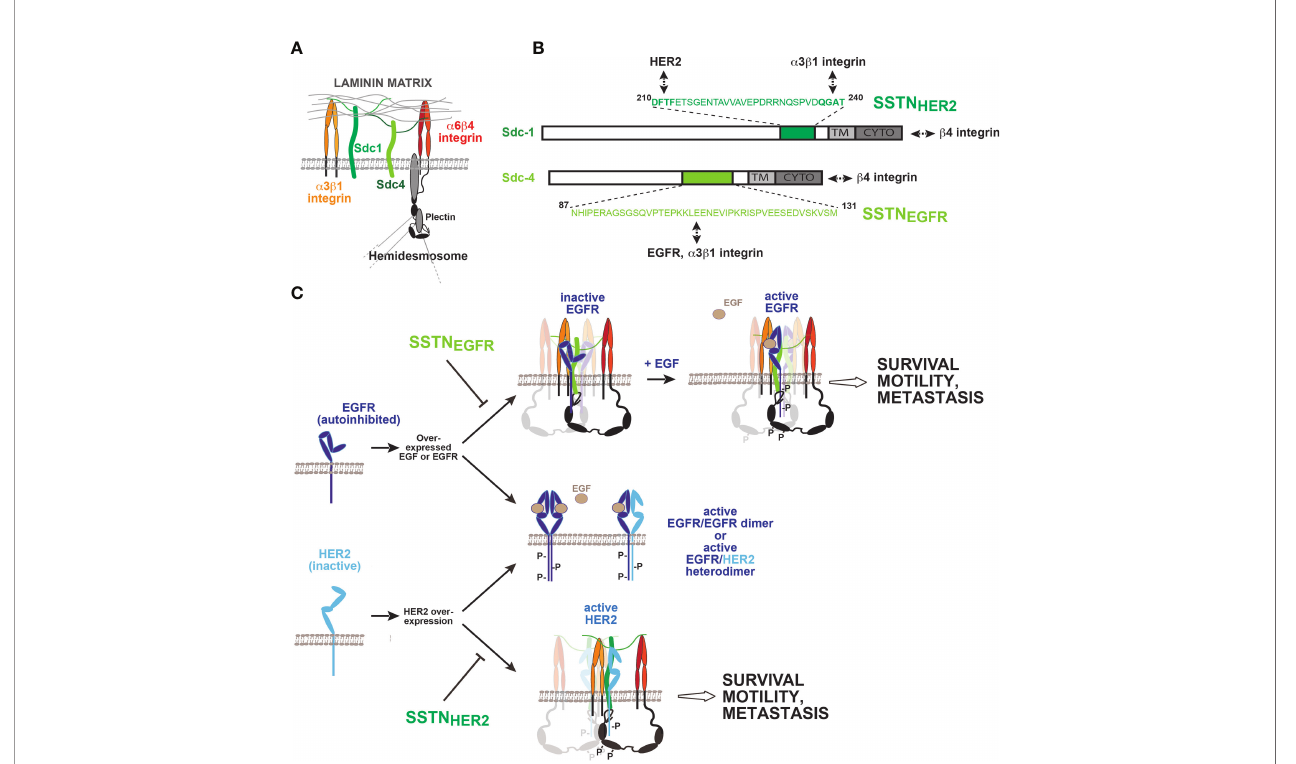
FIGURE 3 | Coupling of EGFR family members to integrins by Sdc1 and Sdc4 regulates wound healing, tumor cell invasion and survival. (A) Syndecans and integrins on quiescent epithelial or endothelial cells. The laminin-332 (LN332) binding a 3 b 1 and a 6 b 4 integrin, along with Sdc1 and Sdc4 via their heparan sulfate chains, mediate binding to LN332-rich basement membrane. The long (>1,000 amino acids) cytoplasmic domain of the b 4 integrin subunit engages the plectrin and BP180 scaffolding proteins, which engage the intermediate fi lament network and help stabilize the incorporation of the a 6 b 4 integrin into hemidesmosomes. (B) Sites of EGFR, HER2 and integrin capture in Sdc1 and Sdc4. The multifunctional juxtamembrane site in Sdc1 captures HER2 and the a 3 b 1 integrin. Multiple binding interactions occur throughout the sequence; nonetheless, the DFTF motif that is also essential for binding VLA-4 plays a prominent role in HER2 binding, whereas a 3 b 1 integrin capture is highly dependent on the QGAT motif. An analogous juxtamembrane site in Sdc4, which bears no homology to the site in Sdc1, captures EGFR and the a 3 b 1 integrin, relying on multiple binding interactions throughout the sequence. Synstatin peptides based on these sites are highly selective for EGFR (SSTN EGFR ) or HER2 (SSTN HER2 ) and displace a 3 b 1 integrin only when coupled with the EGFR family member for which they are speci fi c. In addition to these interactions, the C-termini of the syndecans engage the cytoplasmic C-terminus of the b 4 integrin, which comprises the a 6 b 4 integrin. This is also syndecan-type speci fi c; mutations that disrupt Sdc1 binding having no effect on Sdc4 and vice versa . (C) Formation and activation of syndecan-organized quaternary receptor complexes containing EGFR or HER2. EGFR and HER2 are overexpressed in squamous cell carcinomas, along with EGF. EGFR depends on EGF for dimerization, and to relieve constraints in its extracellular domain that prevent dimerization. HER2 lacks these extracellular constraints but lacks a ligand to promote its dimerization. Relief of the inhibitory constraints in EGFR allows it to form active homodimers or active heterodimers with HER2. Activation of receptor tyrosine kinases causes the breakdown of hemidesmosomes, freeing the cytoplasmic domain of the b 4 integrin to engage Sdc1 and Sdc4. Quaternary receptor complex is formed when EGFR and the a 3 b 1 integrin, or HER2 and the a 3 b 1 integrin assemble with their respective docking site on the syndecans as well. The kinases appear to be captured as monomers and rely on clustering of the complexes to sites of matrix adhesion to be activated. Simple clustering of the syndecan is suf fi cient to activate HER2, but EGFR also requires EGF, ostensibly to relieve the dimerization constraints in its extracellular domain. Several tyrosines in the b 4 cytoplasmic domain become phosphorylated, and support signaling that leads to epithelial cell migration during wound healing, or invasion and survival signaling in tumor cells and endothelial cells engaged in pathological angiogenesis. Synstatin peptides speci fi c for HER2 capture by Sdc1 (SSTN HER2 ) or EGFR capture by Sdc4 (SSTN EGFR ) are highly speci fi c inhibitors of these processes. [See discussion in text, references (81 – 83) and references